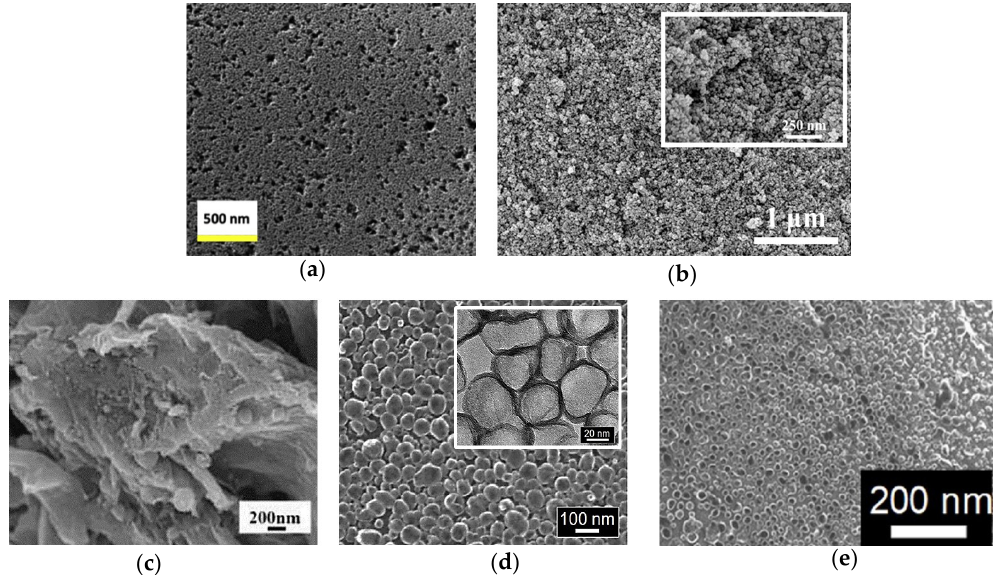
Figure 3. The SEM images of ( a ) HMC2021 [48], ( b ) CA-C [49], ( c ) N-CNOs/mGr [50], ( d ) N-GHBs (inset shows their TEM images) [52], and ( e ) N,S-GHBs [53]. Table 1. The photovoltaic parameters of various carbon electrocatalysts in the DSSCs with an I − /I 3 − redox couple